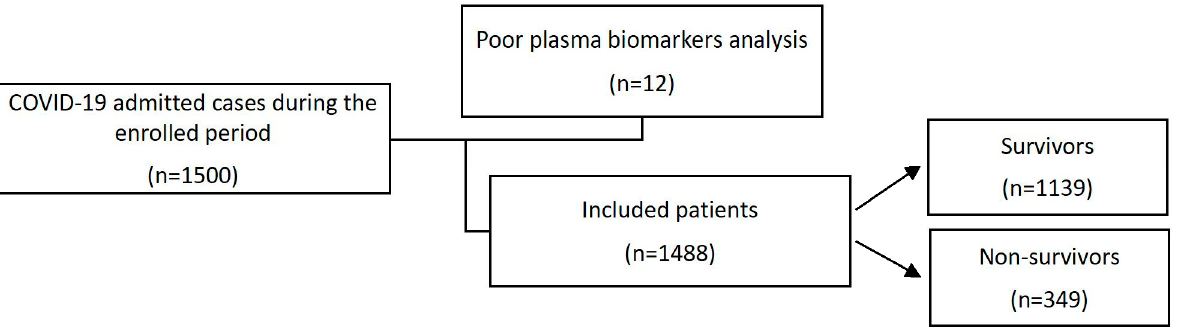
Figure 1. Flowchart of recruited and enrolled study participants.